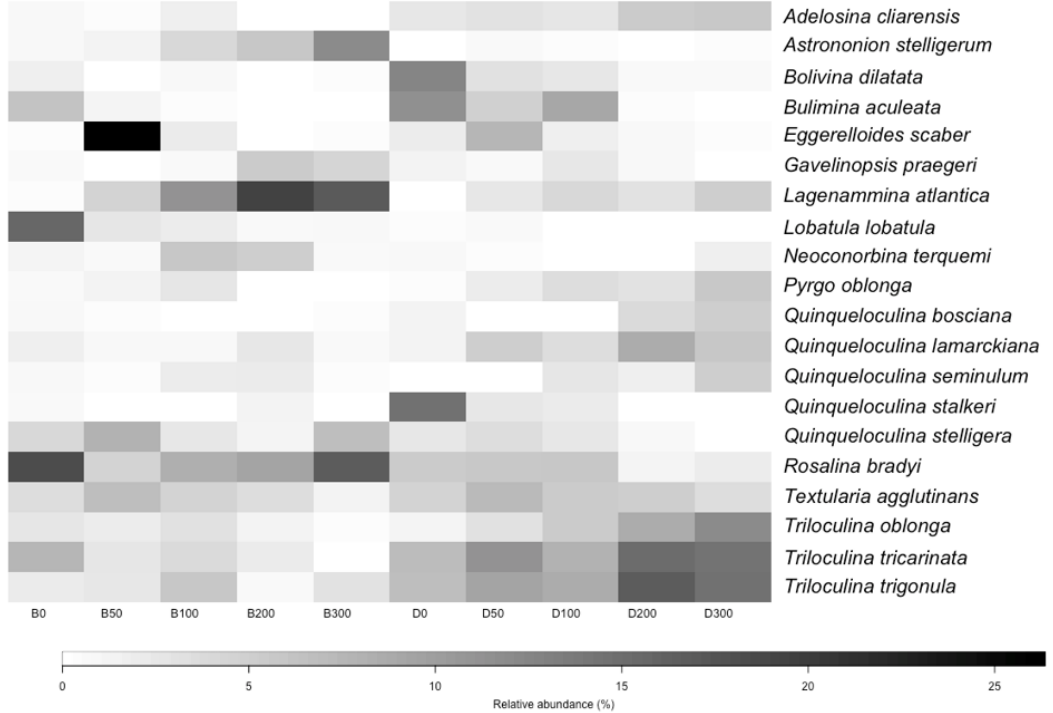
Figure 6. Heat map of the 20 major species (>5% of the total fauna in at least one of the stations from site B and D). In detail, Quinqueloculina lamarckiana and Triloculina oblonga (Figure 7a,b) exhibited maximum relative abundances when the TOC content was low with a distribution